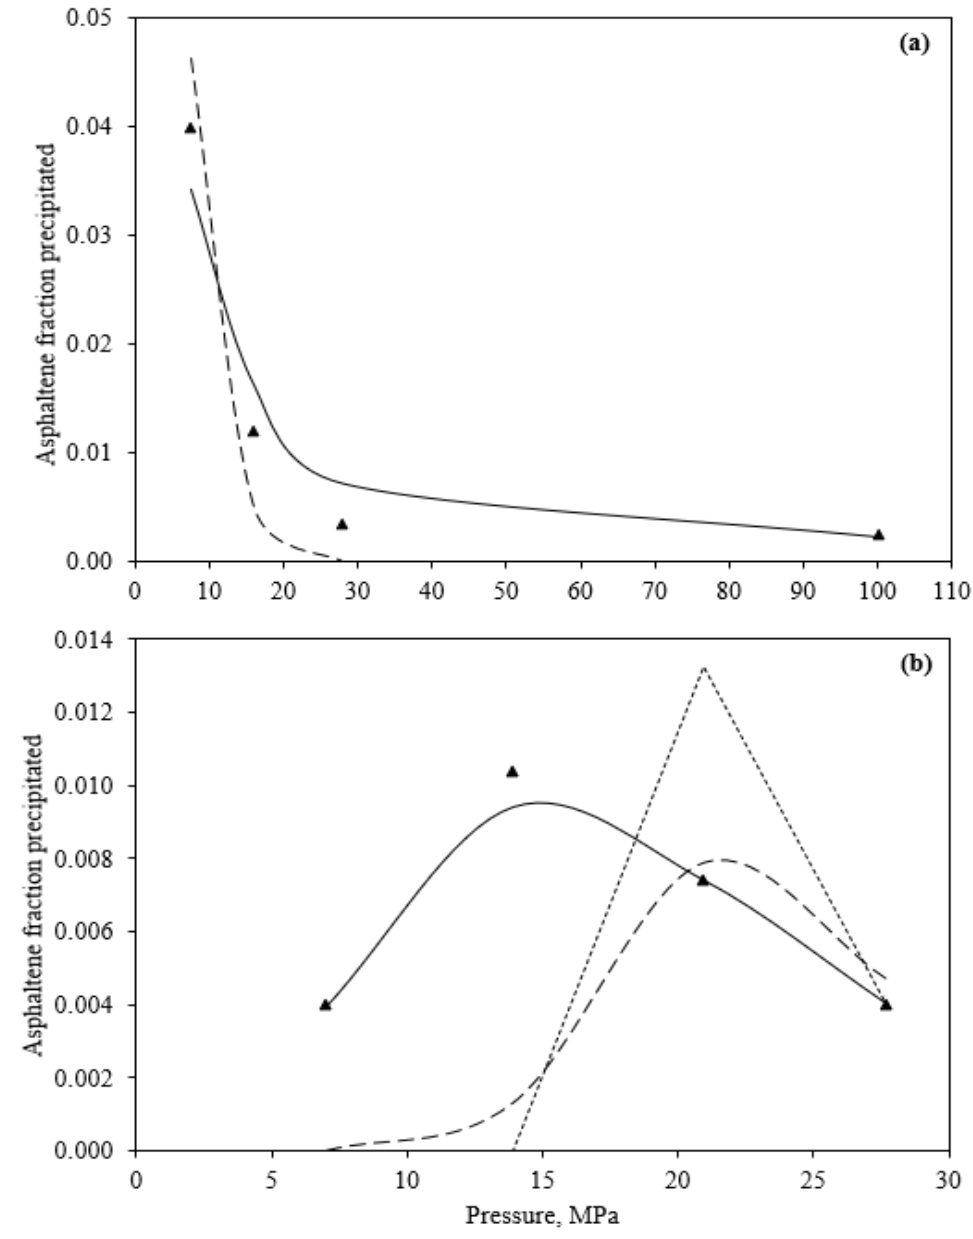
Figure 2. Pressure and temperature effects on precipitated asphaltene fraction calculated by differ- ent models. ( a ) Experimental data ( ▲ ) by Hirschberg et al., at 93 °C, ( ━ ) calculated by Pan and Firoozabadi) and ( ━ ━ ) calculated by Hirschberg et al.). ( b ) Experimental data ( ▲ ) by Burke et al., at 100 °C, ( ━ ) calculated by Shirani, ( ━ ━ ━ ) calculated by Victorov and Firoozabadi) and ( ━ ━ ) calculated by Nghiem.